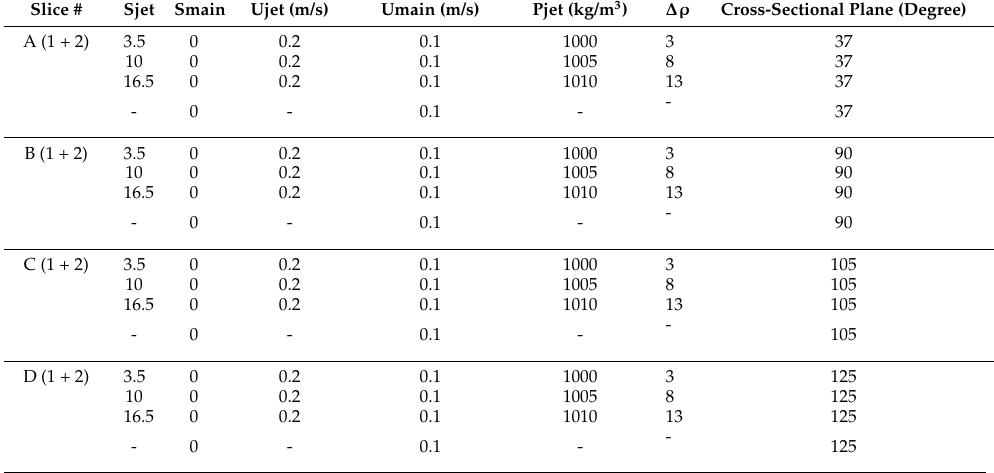
Table 2. Table of